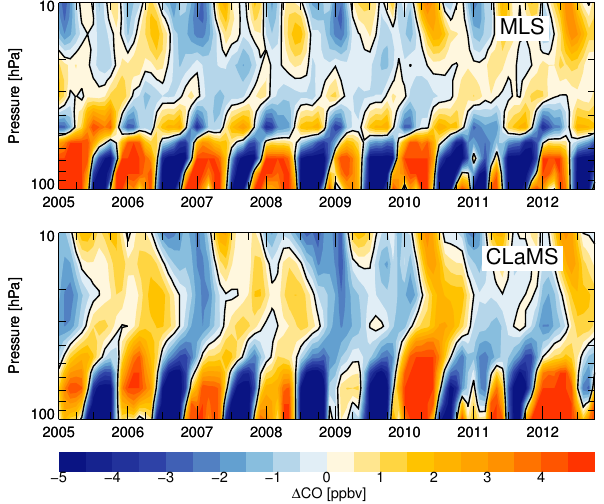
Figure 3. Comparison of CO anomalies, zonally averaged in the latitude band ± 15 ◦ from MLS measurements (top panel) and the CLaMS simulation (bottom panel) for the time period 1 Jan- uary 2005 to 31 October 2012. The CLaMS values were vertically smoothed employing the averaging kernels of the MLS measure- ments. The black lines in both panels indicate where the anomaly is